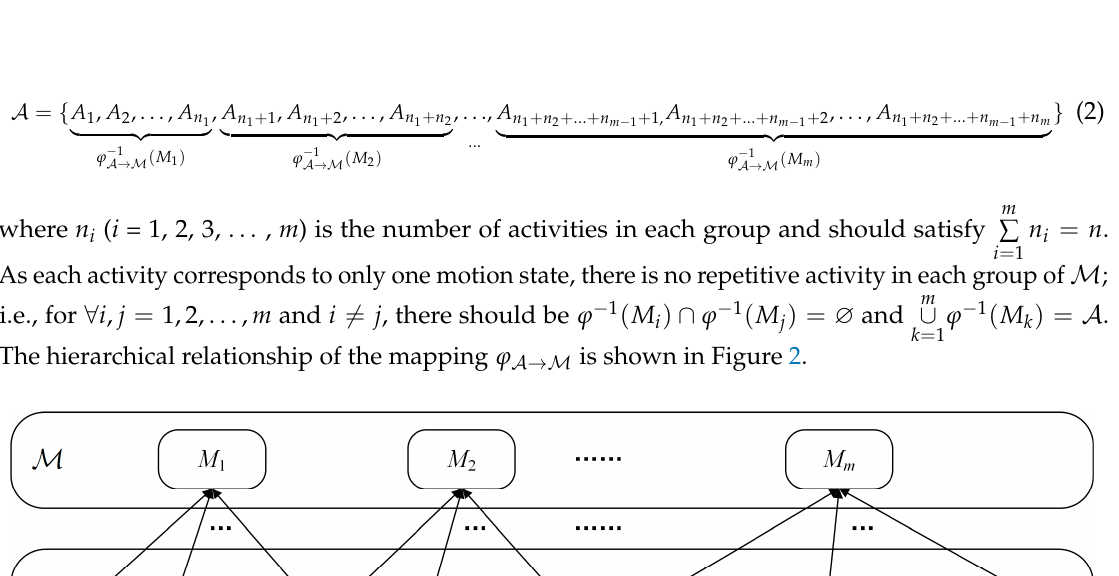
Figure 2. Hierarchical relationship of the mapping ϕ A→M